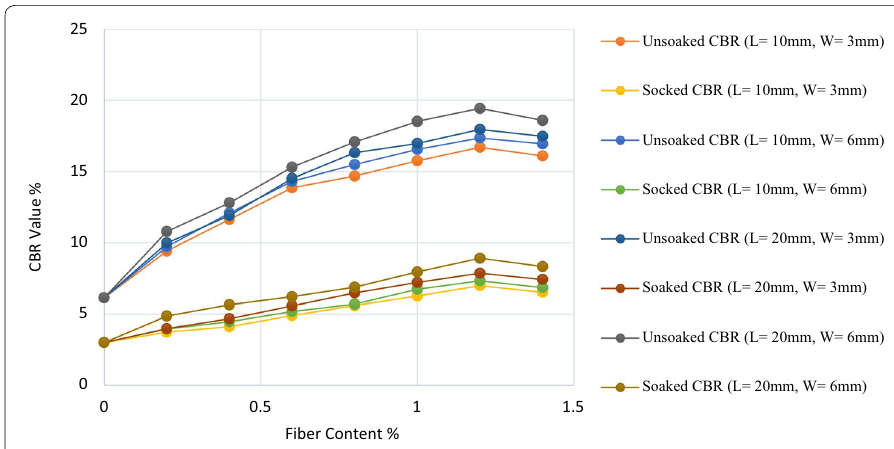
Fig. 5 Variation of CBR value for bamboo fiber at different (content, length and diameter)